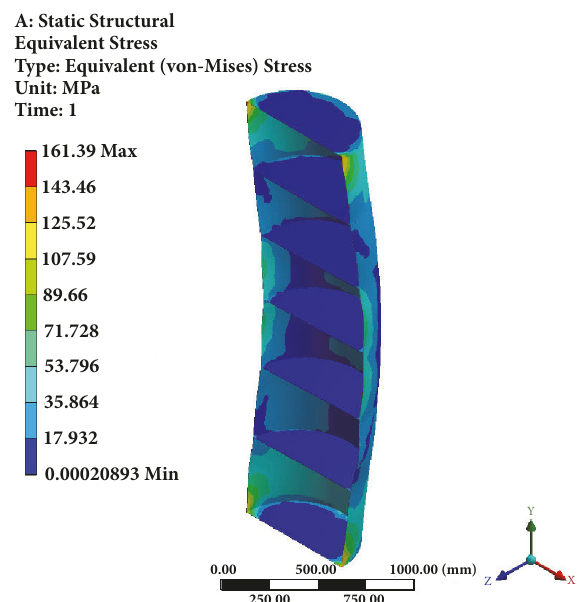
Figure 7: Equivalent stress contour of drag rotor.